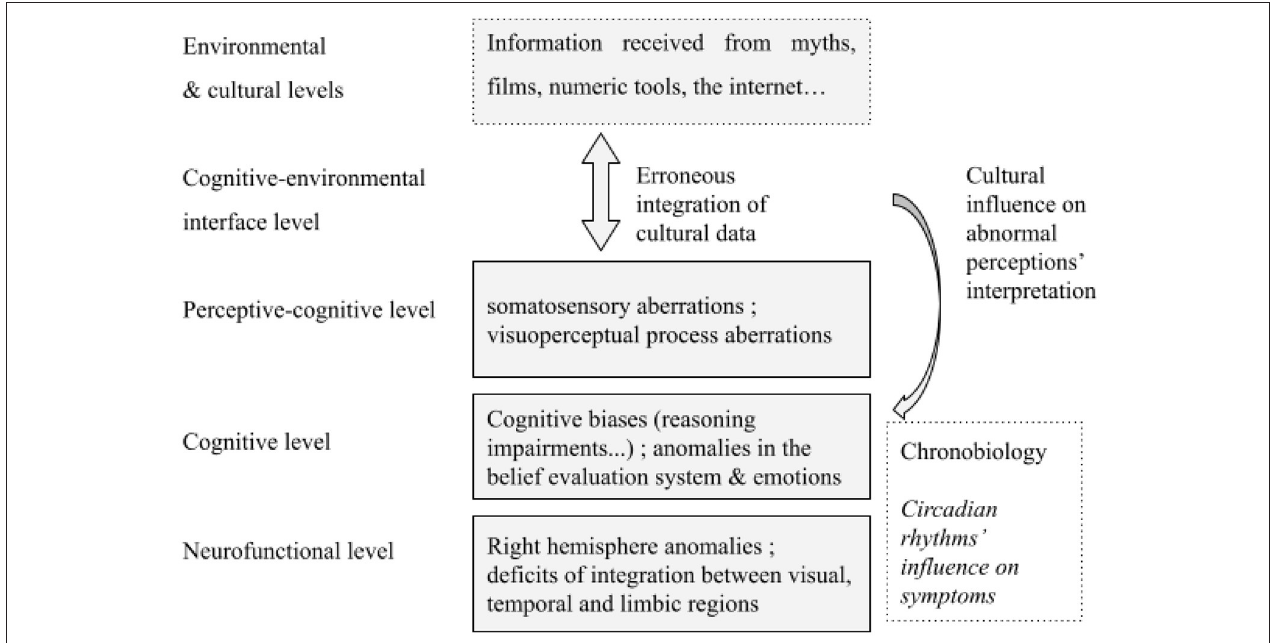
FIGURE 3 | Multi-level hypotheses for clinical lycanthropy